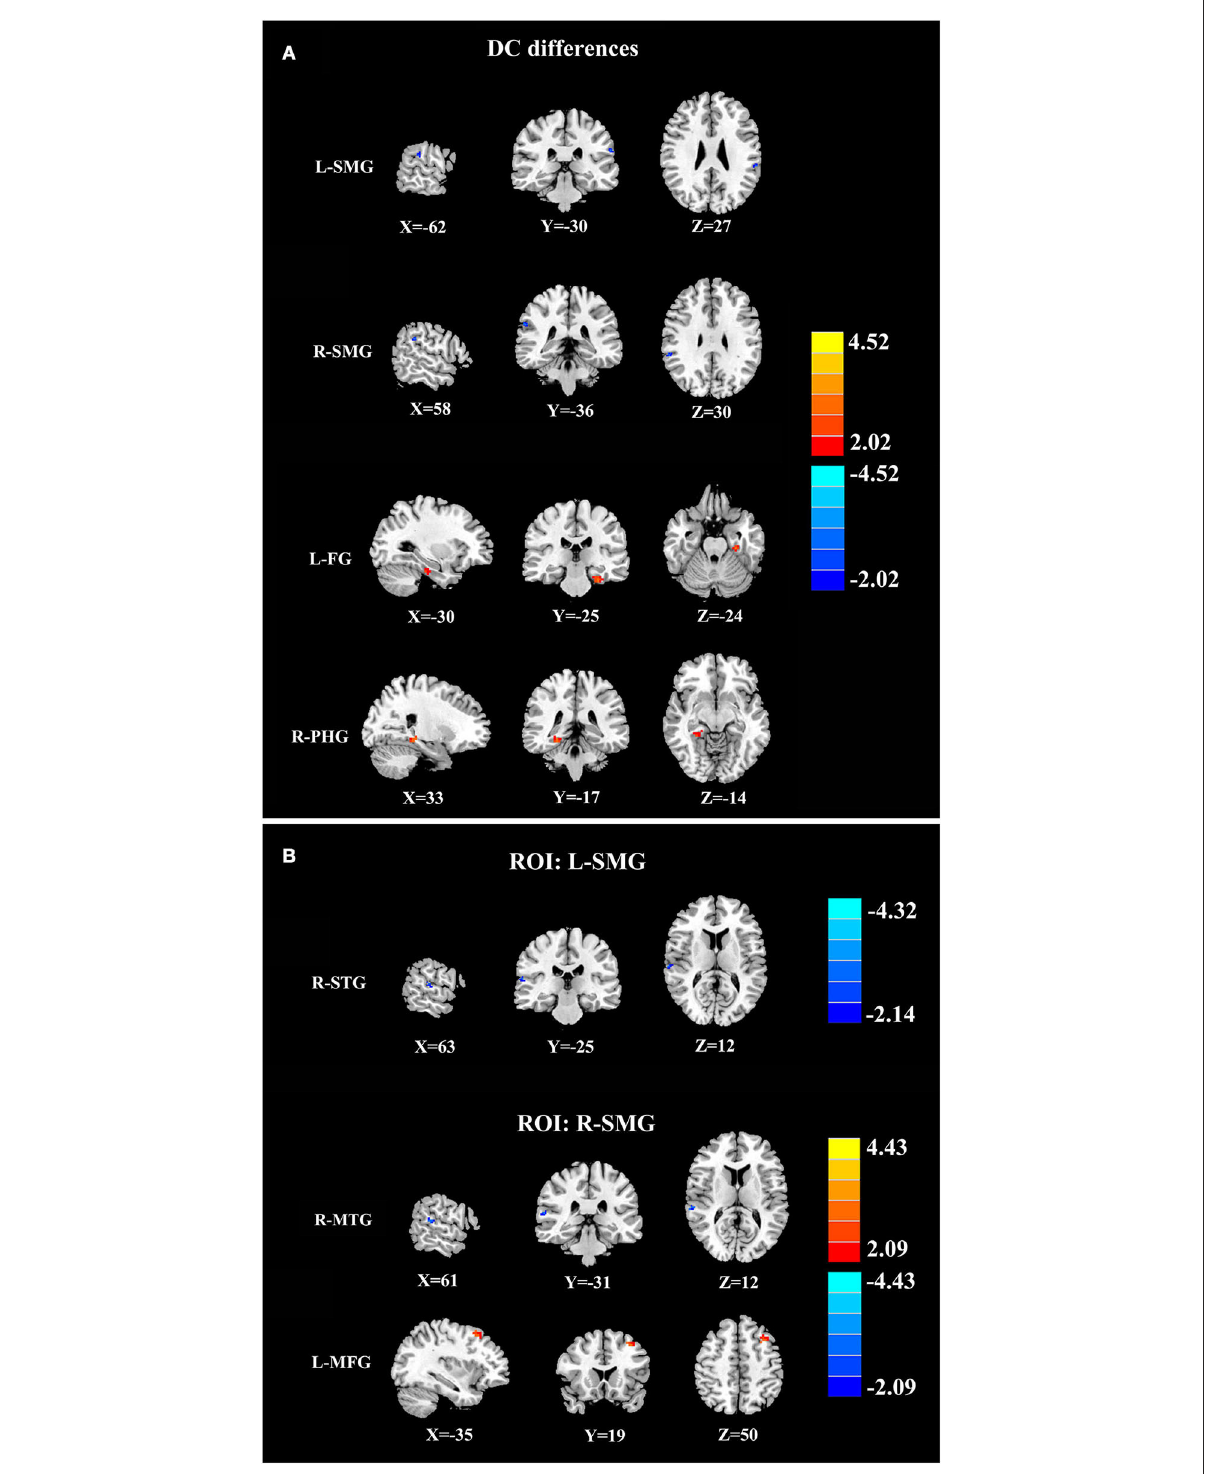
FIGURE2 DC and FC results. (A) DC analysis between patients with ARHL and healthy controls. Compared with healthy controls, patients with ARHL exhibited reduced DC in the left and right supramarginal gyrus (L-SMG and R-SMG) as well as enhanced DC in left fusiform gurus (L-FG) and right parahippocampal gyrus (R-PHG). (B) FC analysis between patients with ARHL and healthy controls. With the seed set at L-SMG, patients with ARHL showed lower FC with the right superior temporal gyrus (R-STG). With the seed set at R-SMG, patients with ARHL showed reduced FC with the right middle temporal gyrus (R-MTG) and increased FC with the left middle frontal gyrus (L-MFG). The significant cluster-level p was set at < 0.05 with Gaussian random field (GFR)